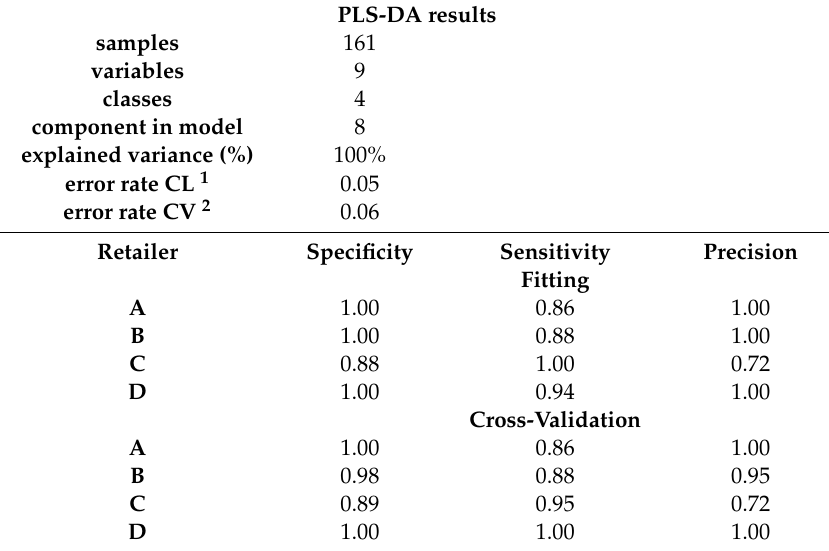
Table 3. PLS-DA classification results in fitting and cross-validation. Cross- validation ‘venetian blinds’ technique was used with the number of cv groups equal to 3. The optimal components for the model was previously calculated using the MatLab toolbox from Milano Chemometrics and Quantitative Structure Activity Relationship (QSAR) Research Group.